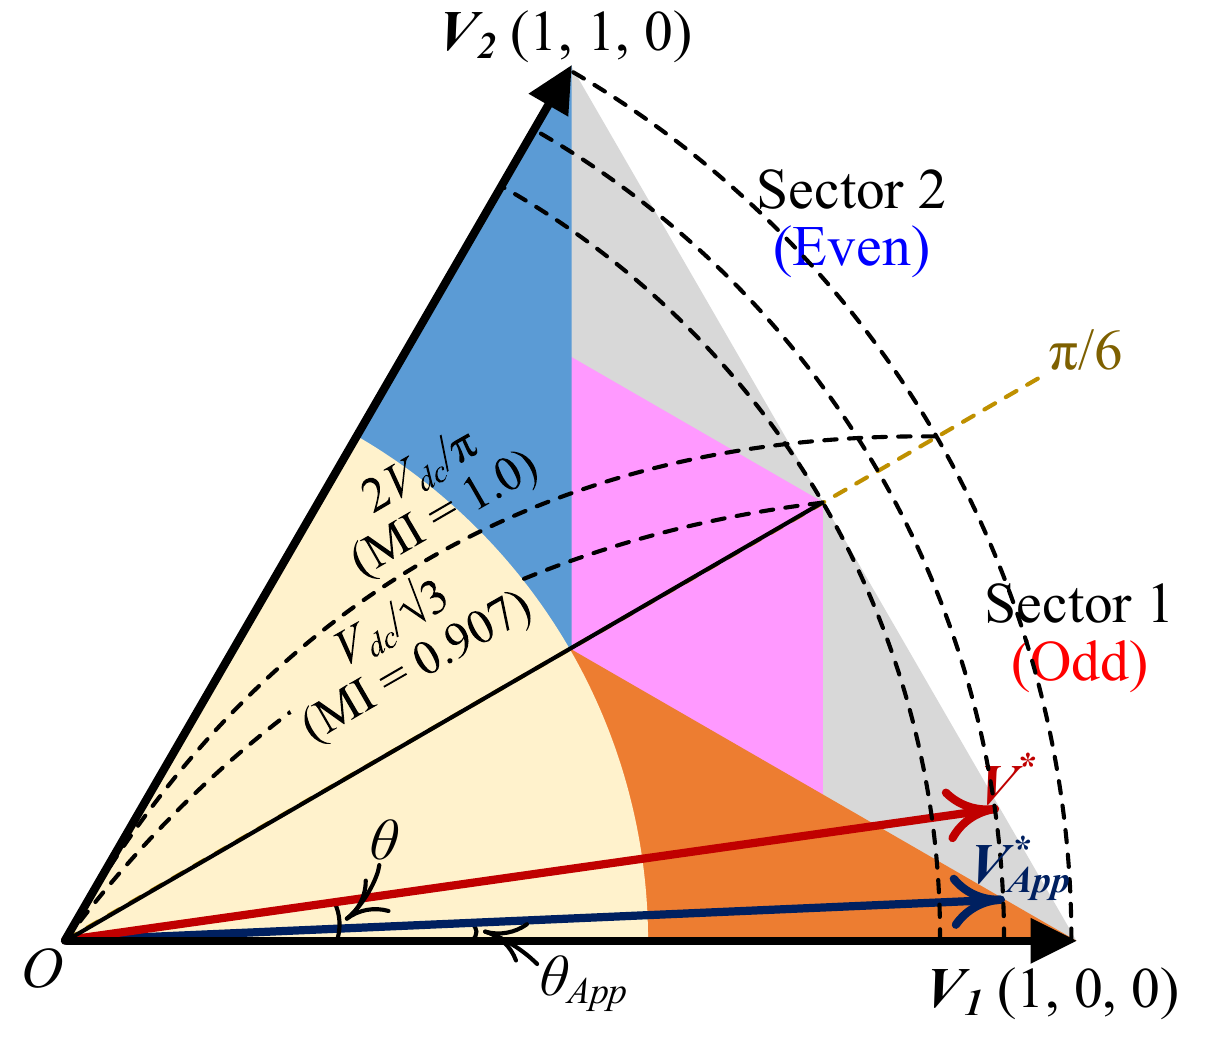
Figure 12. Overmodulation of proposed method in MI range of (0.907, 1.0].